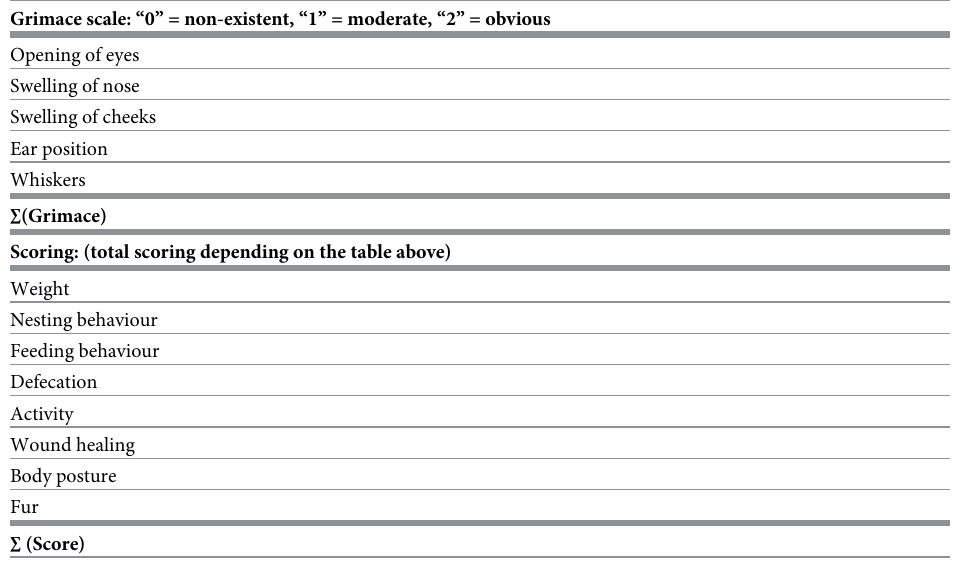
Table 2. Complete postoperative scoring system for mice after implantation of AIW.